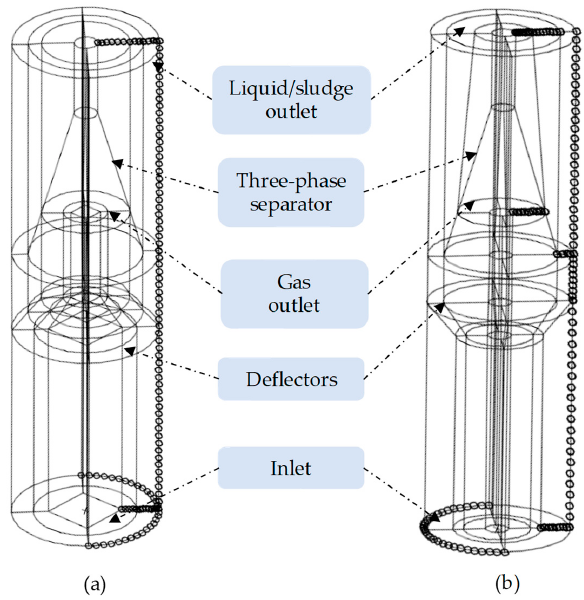
Figure 1. Geometric illustration of meshes in three-dimensional space: ( a ) inclination of the